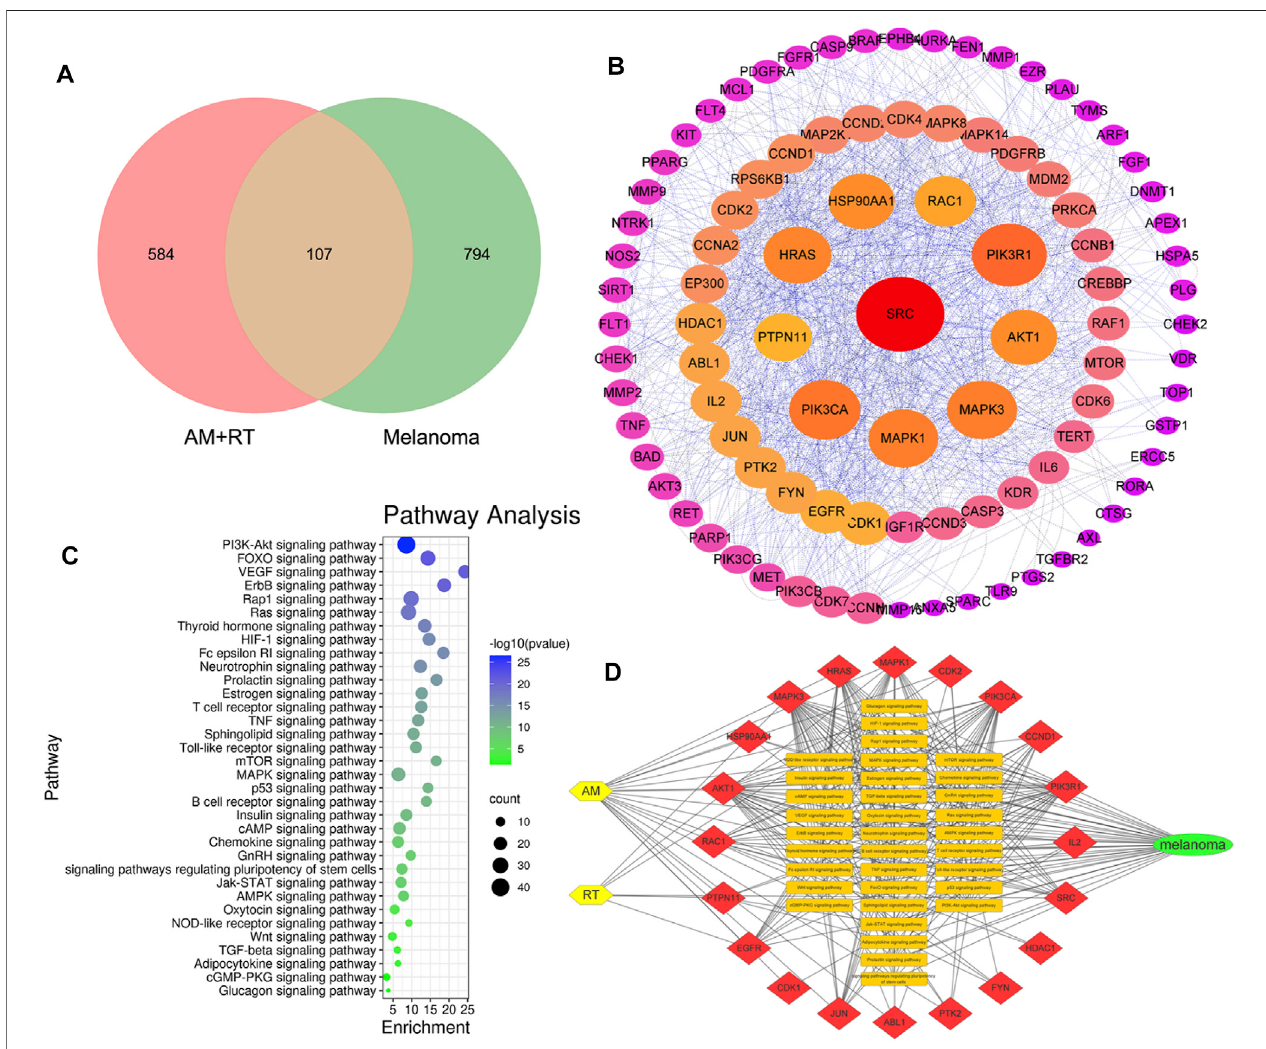
FIGURE 2 | Outcomes of network pharmacology analysis predicted. (A) Venn diagram of AM, RT, and MM. (B) PPI network of common targets. The layout of the three circles was in a clockwise direction according to the nodes from large to small and red to purple. (C) KEGG signaling pathways. The larger the area, the more the counts, and the bluer the color, smaller the p -value. (D) Drug – target – pathway – disease network. The yellow nodes represent herbs, red of the top 20 targets, orange of 34 pathways, and green of MM.